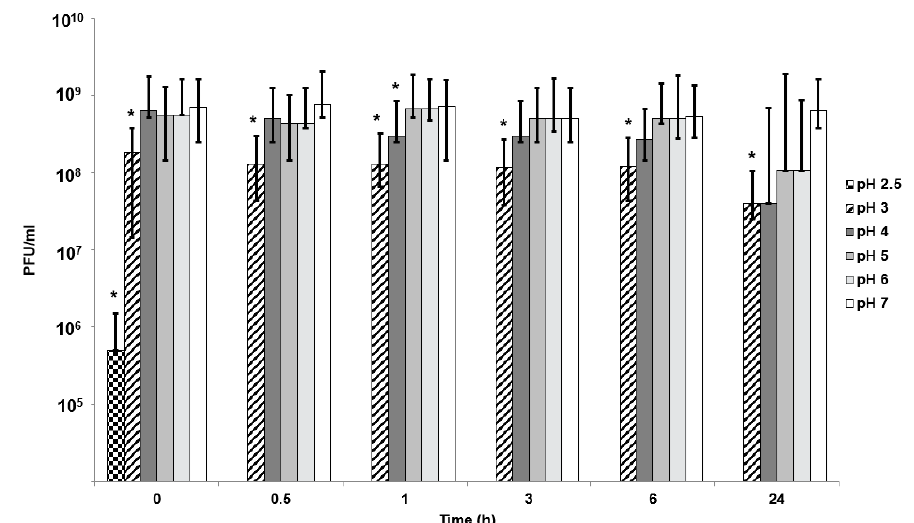
Figure 4. Effect of pH on free phage viability in 0.2 M NaCl solution. *Significantly different phage titres using a 2-sample t -test at each condition compared with phages exposed to pH 7 at the corresponding time point. Time point 0 h denotes the time between 0–10 min for phages exposed to all pH values except pH 2.5, where the phage titre reduced rapidly, and data is plotted 10 s post exposure.